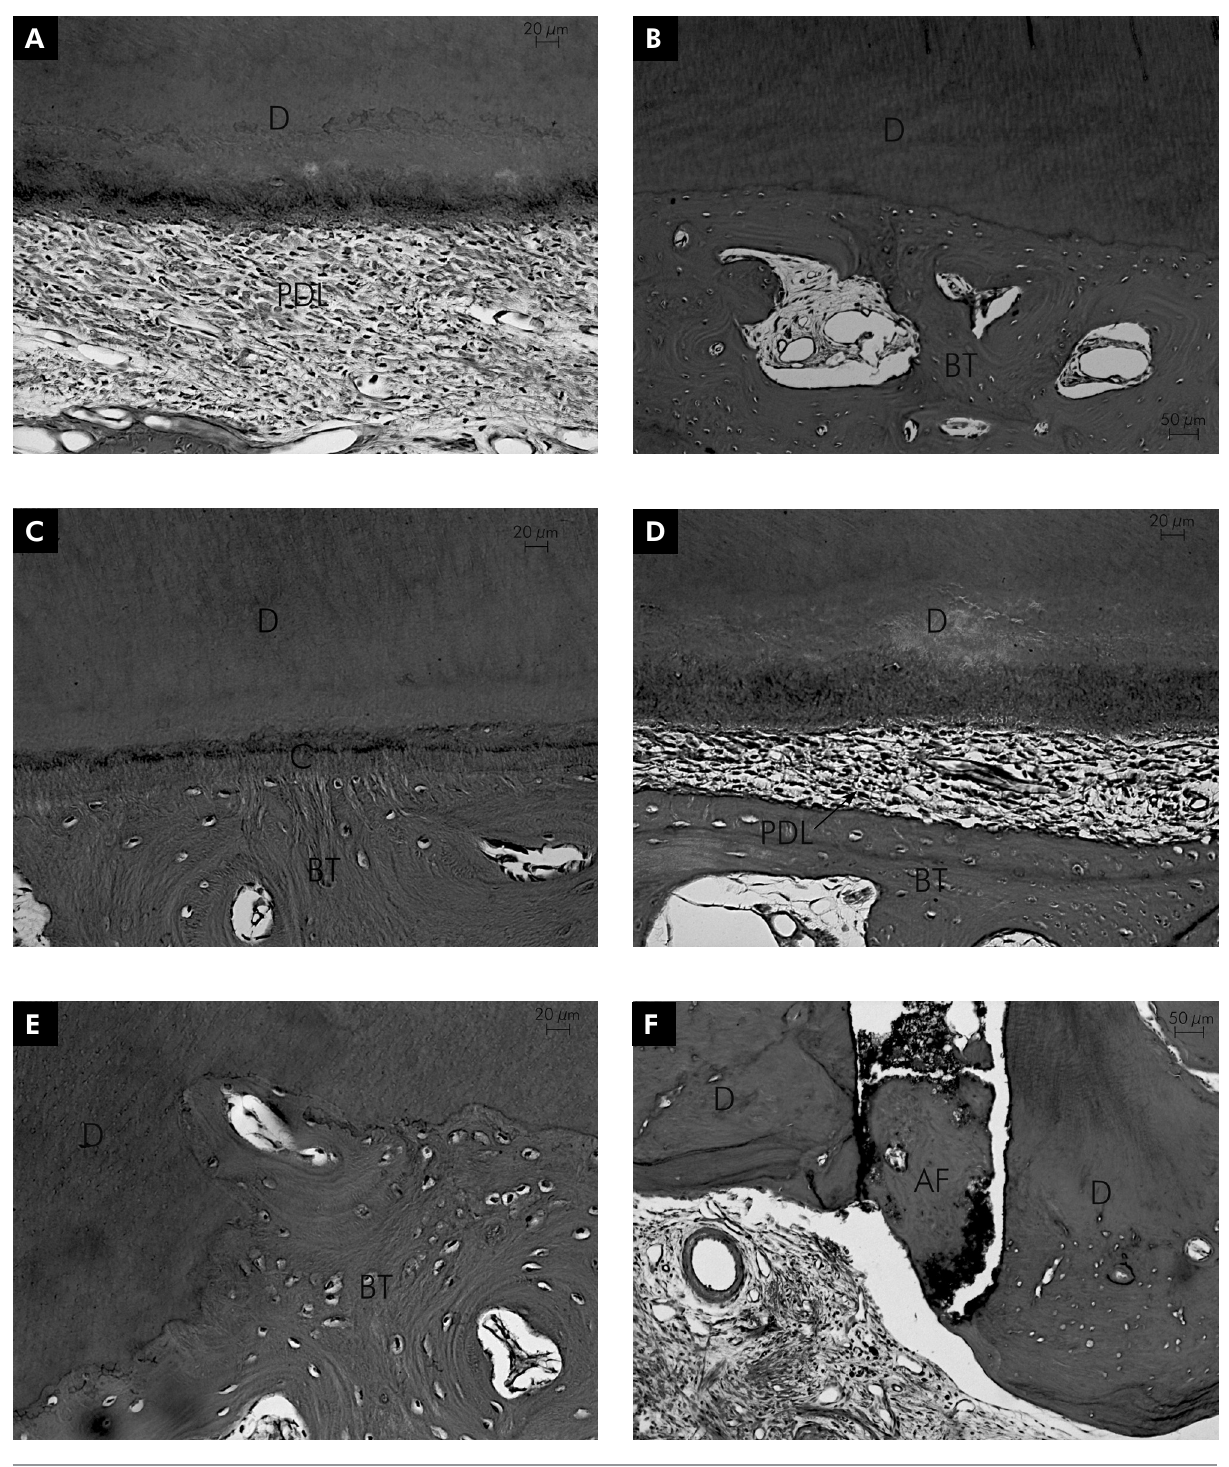
Figure 1. A - Ca(OH) - PDL space filled by connective tissue with collagen fibers parallel to the root surface. Dentin (D). 2 H. E. B - Ca(OH) - PDL space filled by newly formed bone tissue (BT). Dentin (D). H. E. C - Ca(OH) 2 intimate contact with the cementum (C), characterizing an area of ankylosis. H. E. D - MTA - The PDL space is narrowed and filled by connective tissue with collagen fibers parallel to the root surface. Dentin (D). H. E. E - MTA - Root dentin (D) replaced by newly formed bone tissue (BT). H. E. F - MTA - Biological seal of the apical foramen (AF) with the presence of newly formed cementum. Dentin (D). H. E.